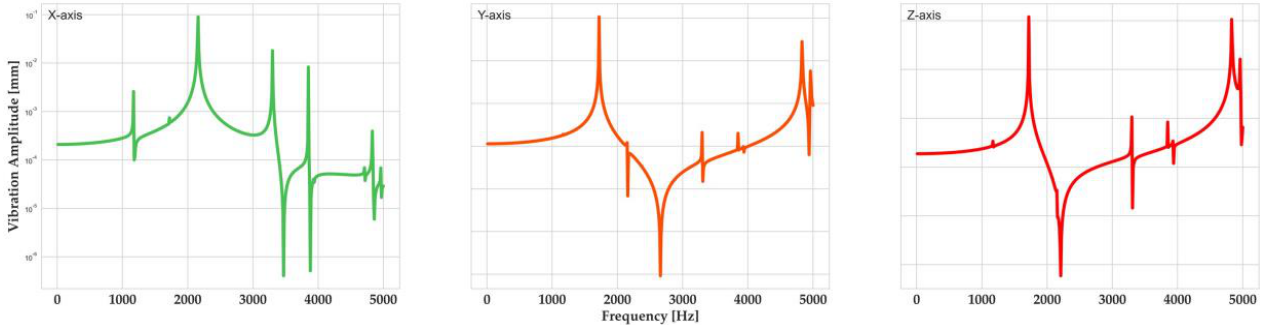
Figure 5. Vibration amplitudes at the sensor-integration point